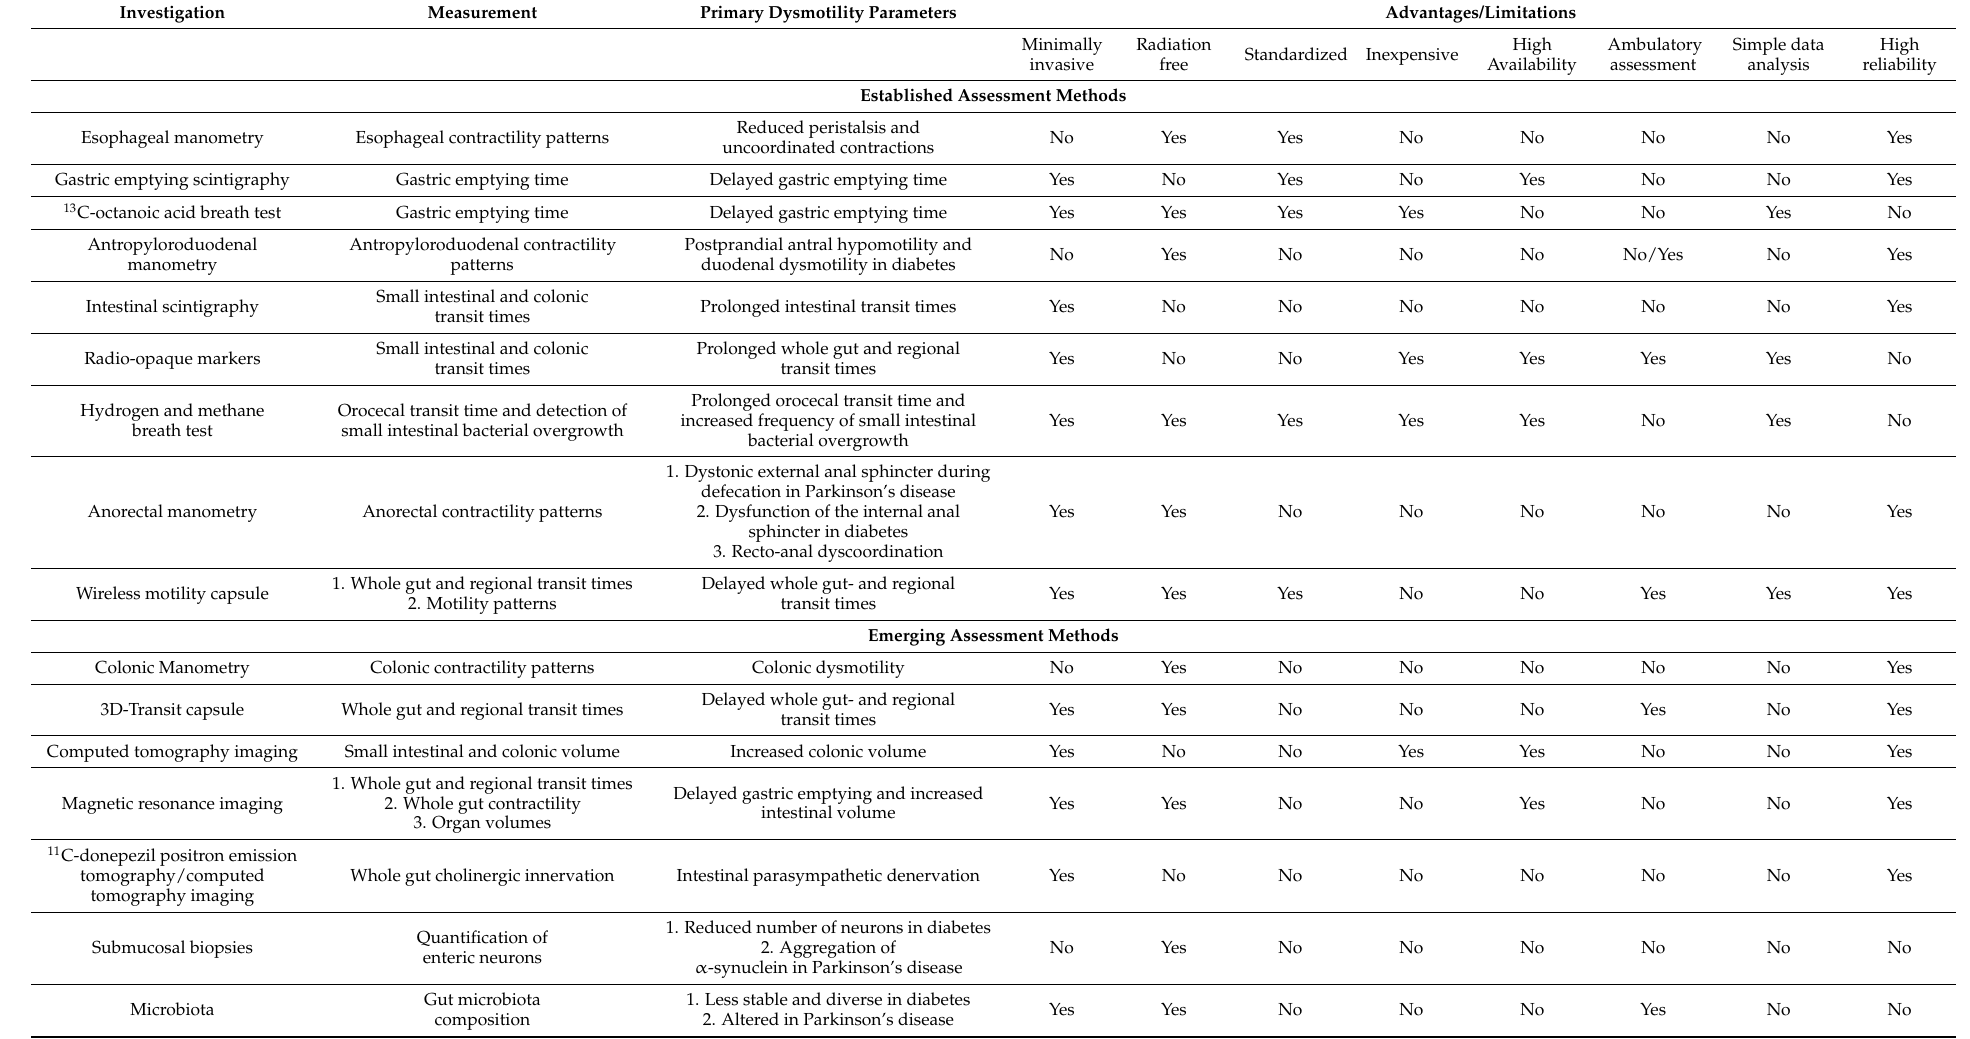
Table 1. Established and emerging methods for assessment of gastroenteropathy in autonomic